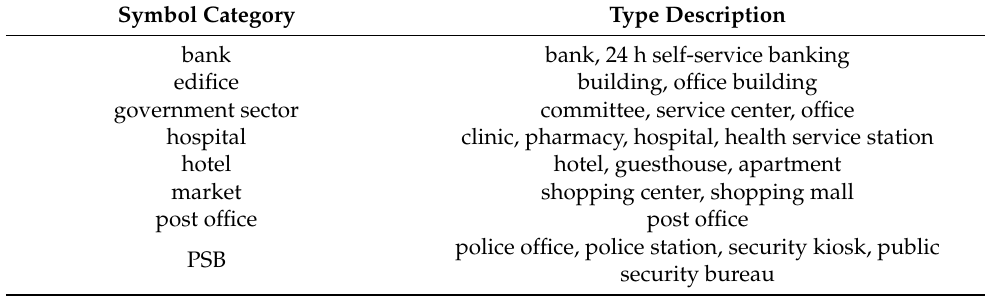
Table 2. POI type division